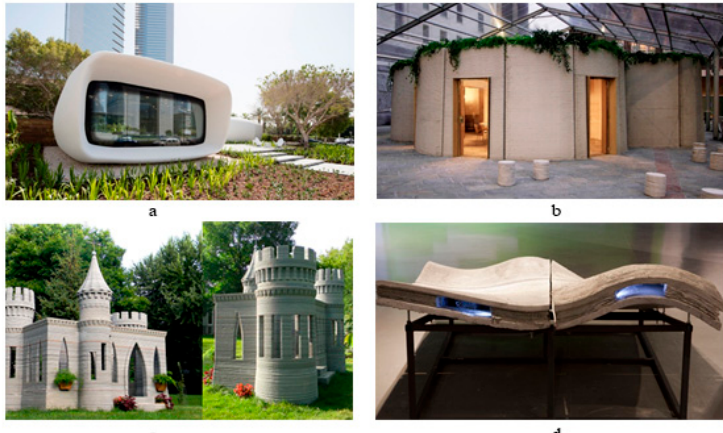
Figure 12. Several architectural applications and elements. ( a ): “The Office of the Future” (Reproduced from [60]). ( b ): “3D Housing 05” (Reproduced from [61]). ( c ): “3D printed concrete castle” (Reproduced from [62]). ( d ): “Loughborough University project” (Reproduced from [63]).